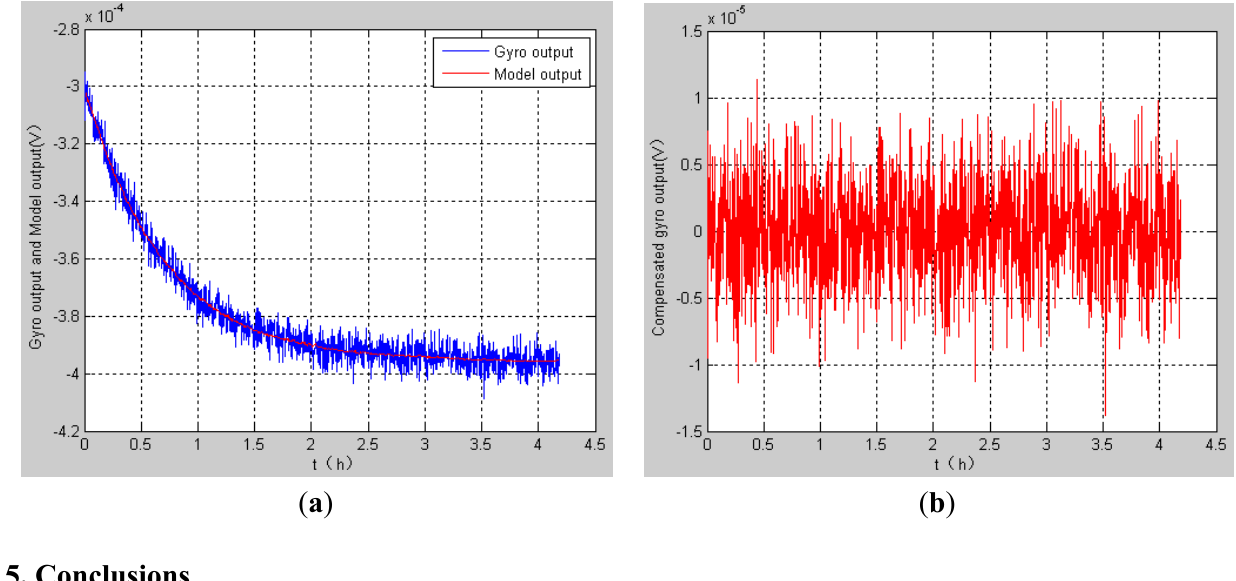
Figure 6. The output of the gyro. ( a ) The uncompensated output of the gyro from room temperature to − 20 °C; ( b ) The compensated output of the